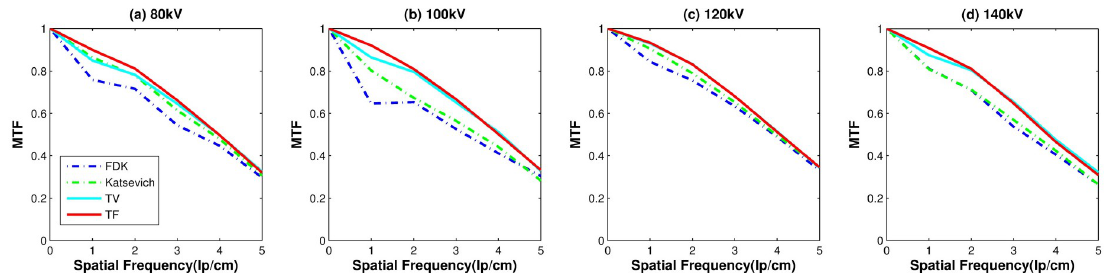
Fig 5. Image resolution measure: Results of MTF curves with the different reconstruction algorithms over various voltage levels. The red line on the Fig 1(a 0 ) is used to compute LSF and MTF.